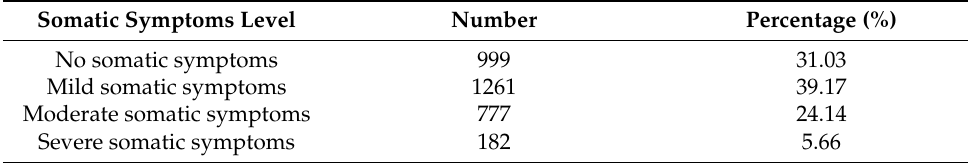
Table 1. Somatic symptoms of medical students.